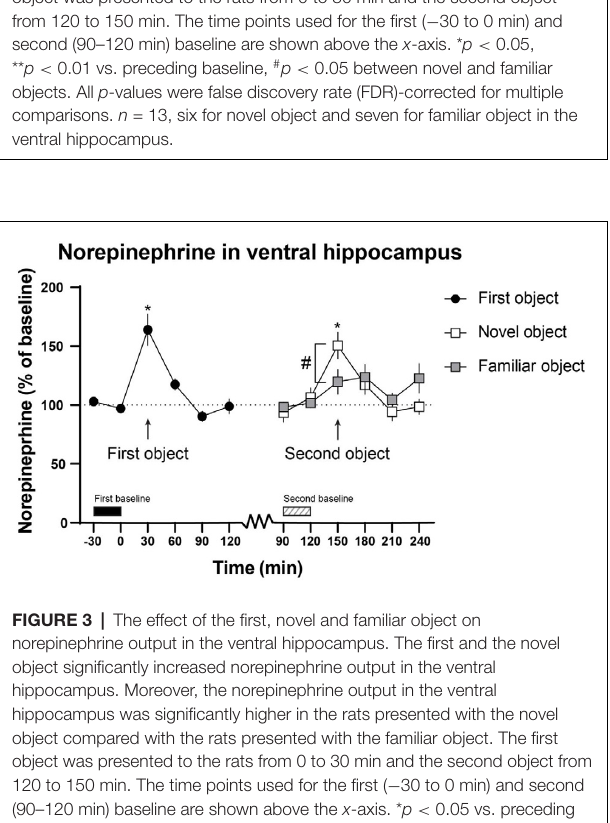
Introduction of the first, novel object significantly increased ventral hippocampal dopamine output (155.8 ± 13.4%) compared with baseline values (101.4 ± 2.8%; t (12) = 4.320, p = 0.008; Figure 2